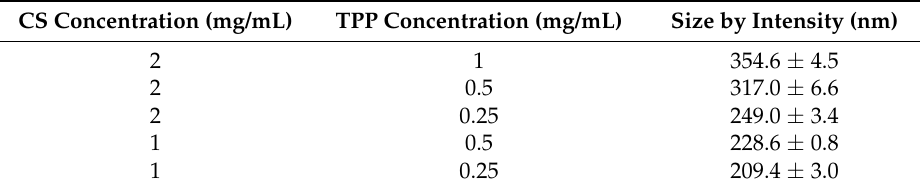
Table 1. The effect of chitosan (CS) and tripolyphosphate (TPP) concentration on the nanoparticle size, at a constant CS to TPP mass ratio of